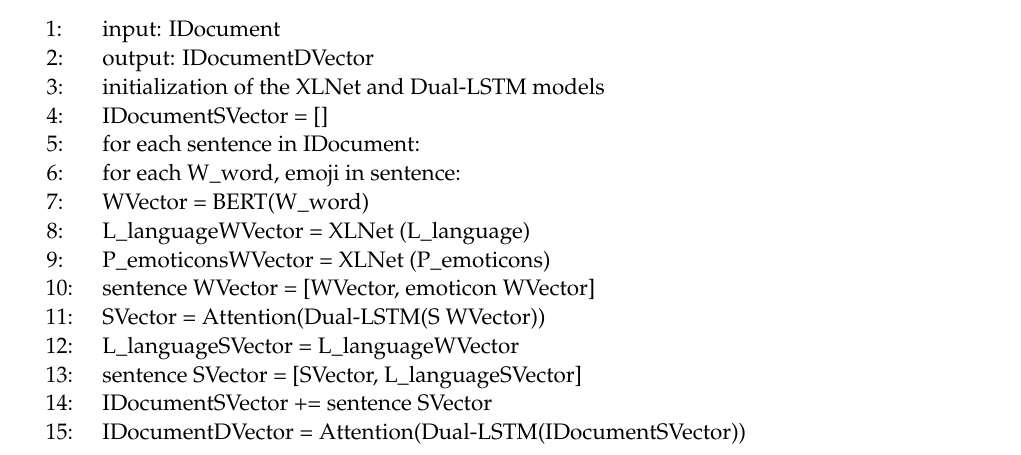
Algorithm 1: Multi-Fold Dimensional Modeling Method for Sentiment